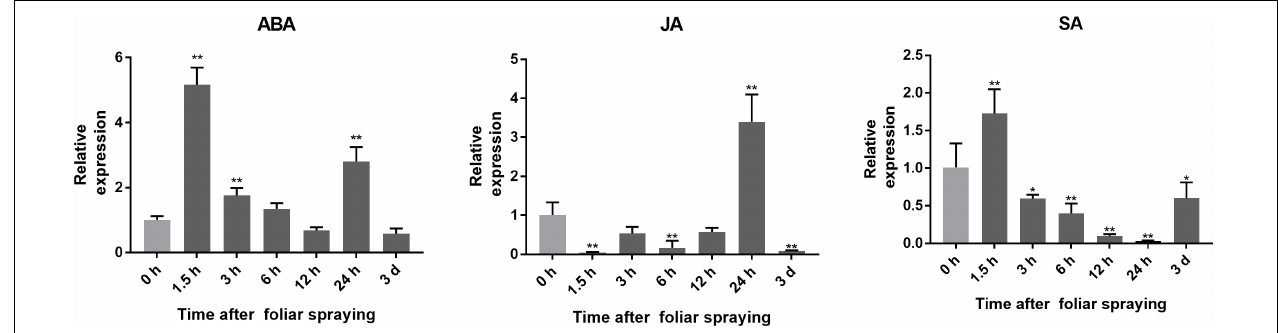
FIGURE 1 | Expression of SlGATA17 induced by exogenous hormones. Error bars represent the SD of triplicate experiments. Vertical bars with * and ** represent significant differences compared with 0 h, analyzed by one-way ANOVA ( P ≤